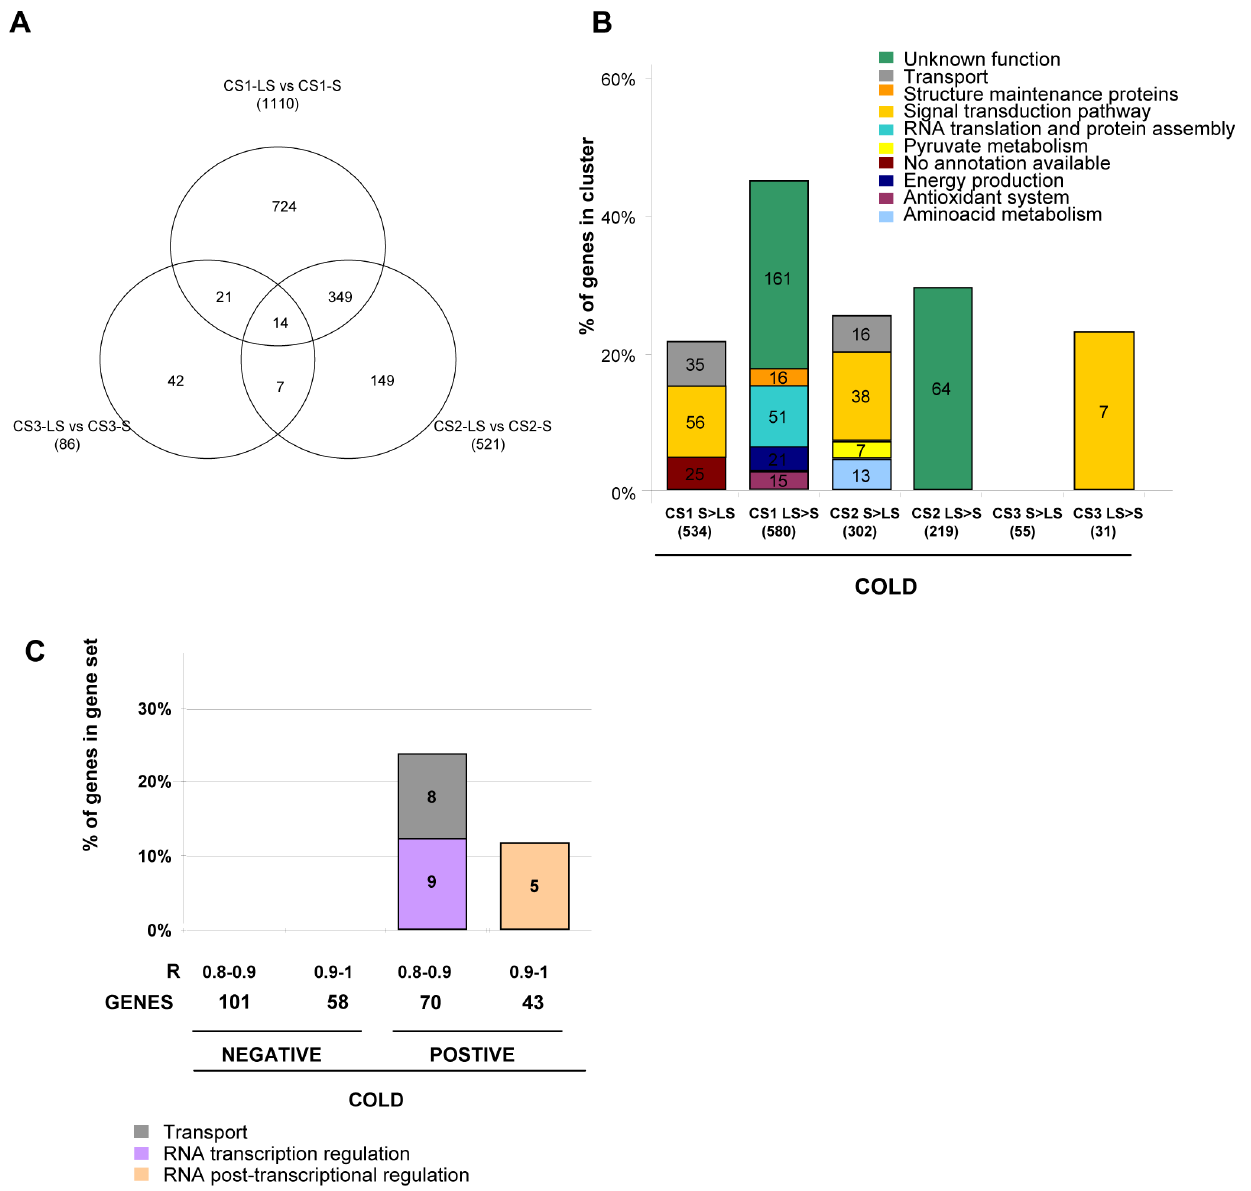
Figure 2. Differential gene expression between the S and LS fruit across the cold storage CS series. A) A Venn diagram depicting the differentially expressed genes (FDR , 0.05 and q-value , 0.05) between tolerant and sensitive fruit at each time of cold storage. B) The over- represented functional categories (p-value 0.05) corresponding to the differentially expressed genes between the LS and S pools at each time of cold storage. C) The functional categories enriched in the genes whose expression profiles correlated with the projected MI fruits should have when shelf life ripened. Pearson: 1 , r , 0.9 and 0.9 , r 0.8. M=mature fruits, R=mature with 2–4 days ripening at 20 u C, CS1=M + 1 week cold storage at 5 u C, CS2=M + 2 weeks cold storage at 5 u C, CS3=M + 3 weeks cold storage at 5 u